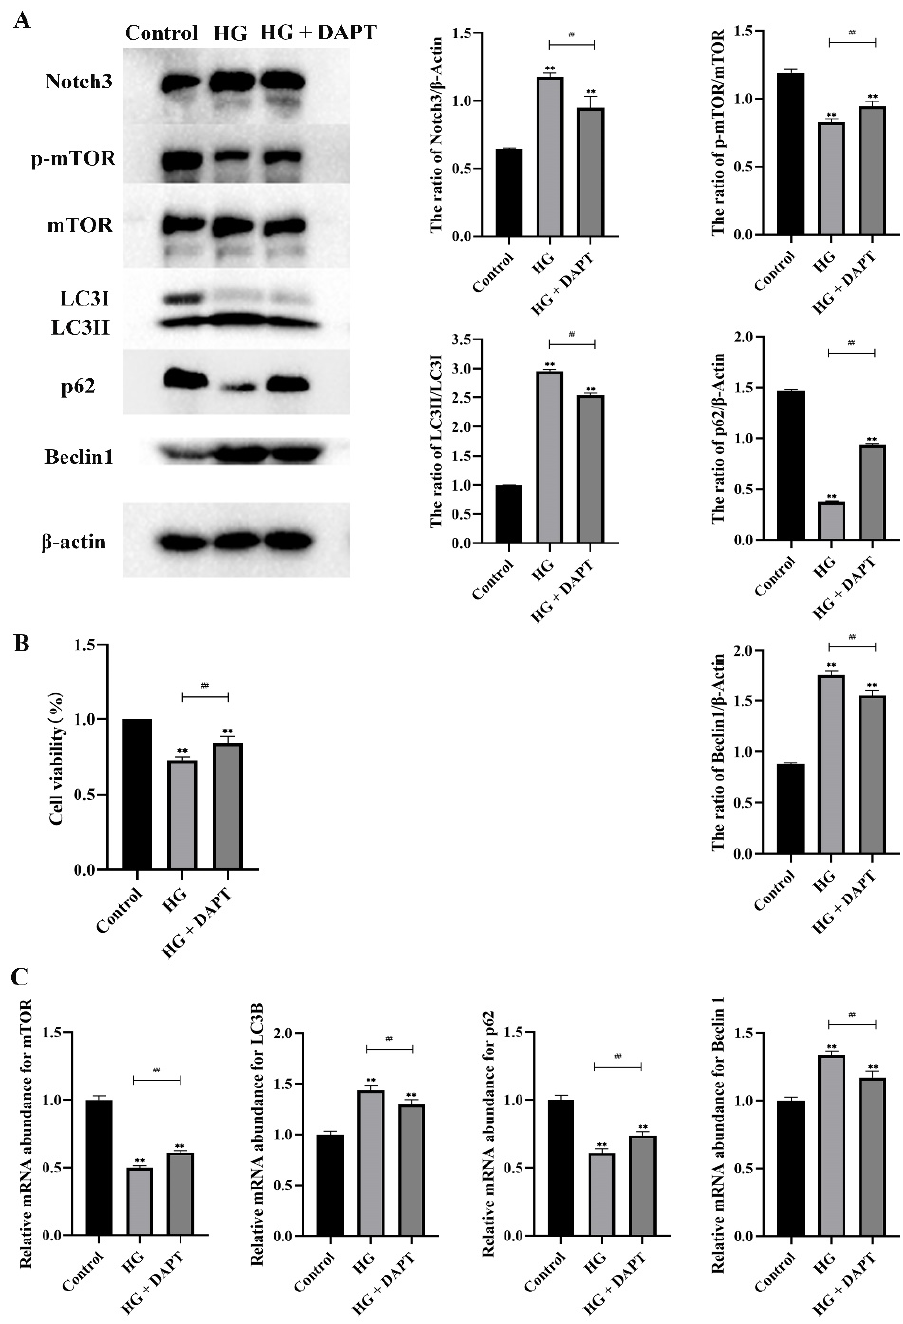
Figure 6. Notch3-mediated mTOR signaling pathway was involved in HG-induced autophagy in MDBK cells. MDBK cells are pretreated for 6 h with 10 µM DAPT, and then stimulated for another 24 h with 25.5 mM glucose. Western blot, CCK-8 assay, and qRT-PCR were used to assess protein expression, cell viability, and gene expression, respectively. ( A ) The protein level of Notch3, mTOR, p-mTOR, LC3-II/I, p62, and Beclin1; ( B ) The cell viability; ( C ) The mRNA expression level of Notch3, mTOR, LC3B, p62, and Beclin1. ** p < 0.01 compared with control group; ##: p < 0.01.